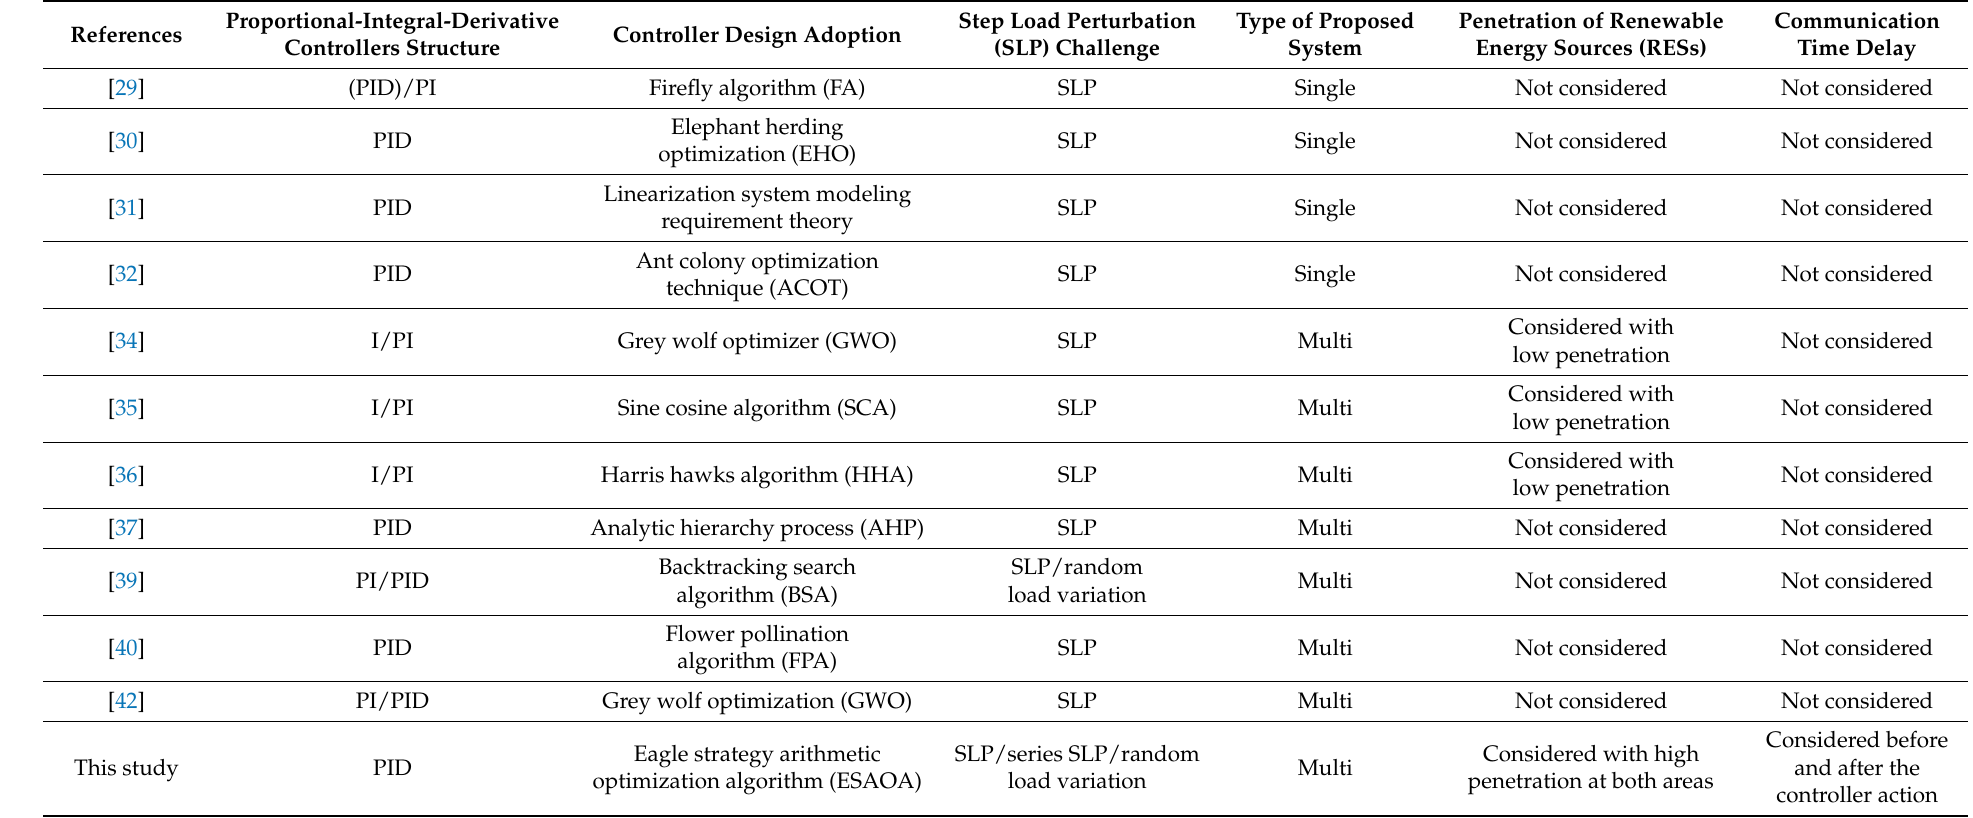
Table 1. Comparison between the motivation of current work and other published